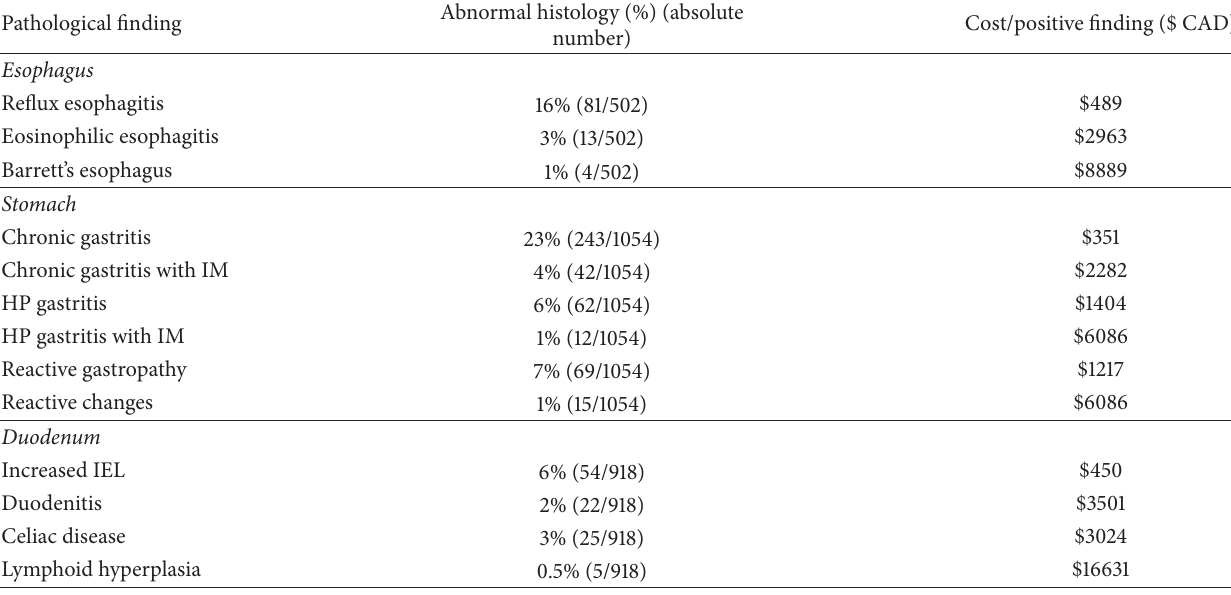
Table 3: Pathological diagnosis on biopsy of normal upper GI tract and cost per positive finding.